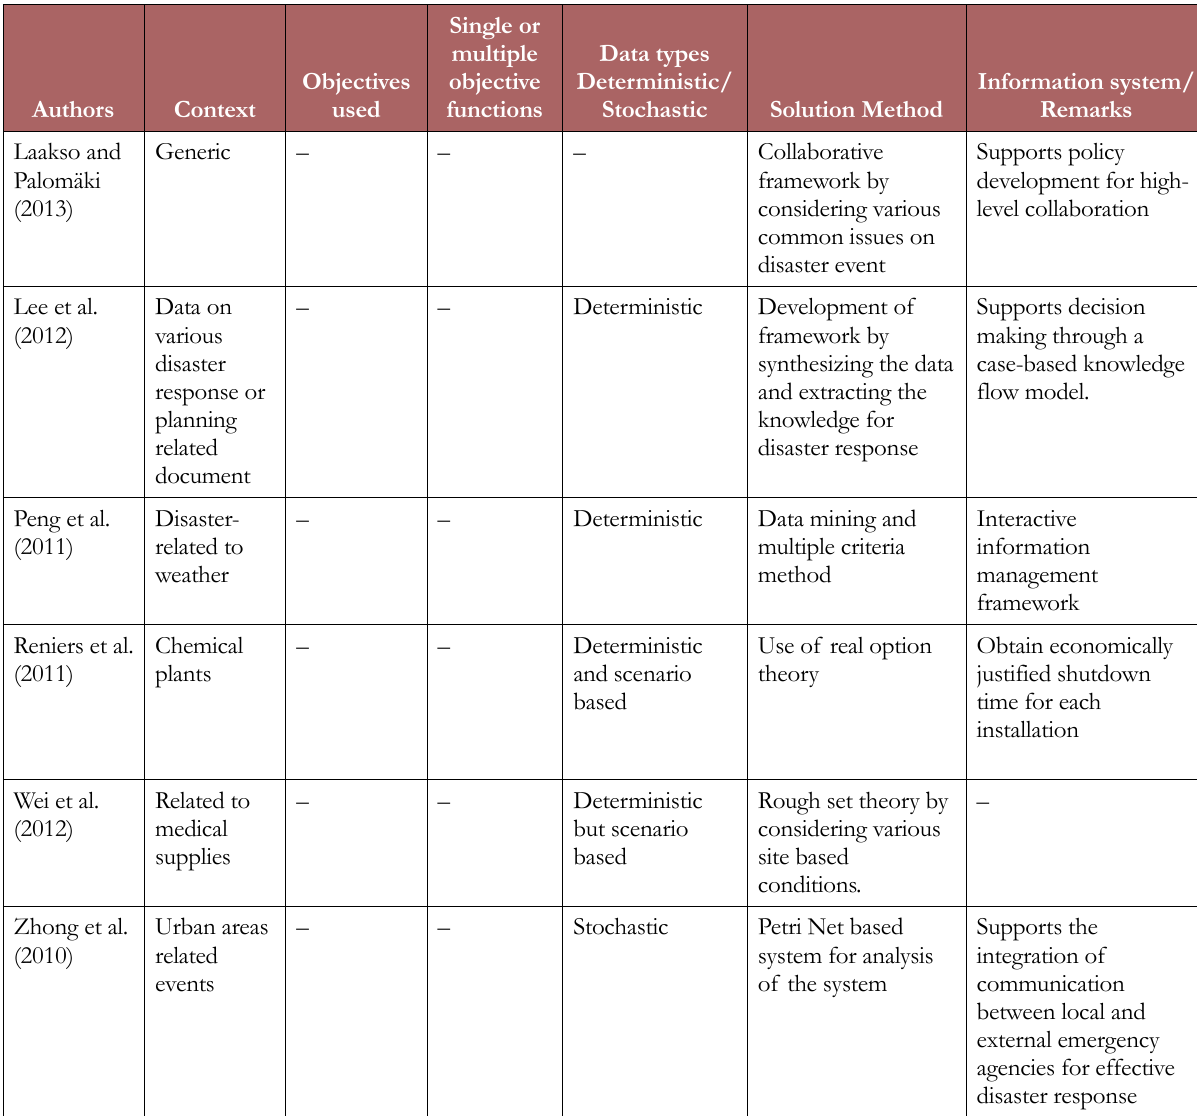
Table 2. Modeling frameworks for reactive